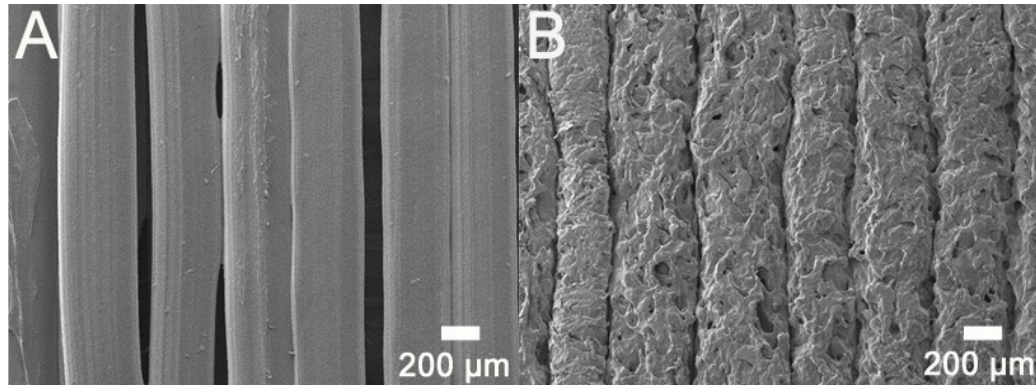
Figure 3. Photo of the fractured specimens.